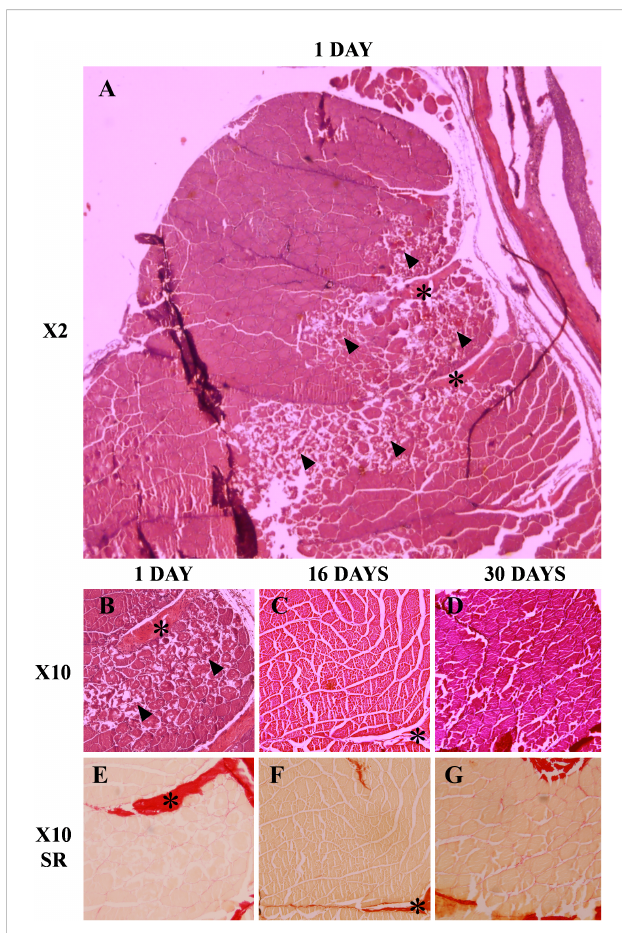
FIGURE 1 Histological evaluation of the muscle regeneration process at 1, 16 and 30 days post-injury. Muscle sections (7-10 µm) were stained with hematoxylin/eosin (A-D) and Sirius red (E-G) . The arrowheads mark the presence of muscle fi bers in the process of necrosis and the asterisks mark the